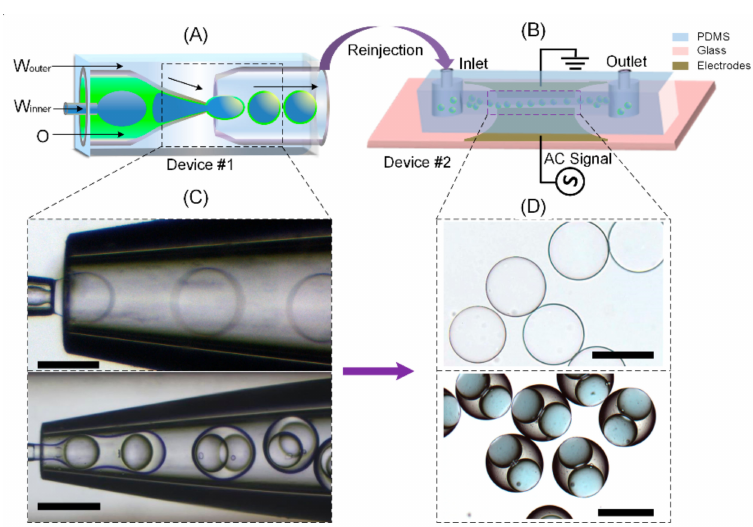
Figure 1. Generation of double emulsion droplets with single and dual cores. W outer , outer aqueous phase; W inner , inner aqueous phase; O, PDMS oil phase. ( A ) Schematic illustration of the glass capillary chip for droplet preparation; ( B ) The PDMS chip for droplet manipulation. The microscopic snapshots of droplet generation in the microfluidic chips and the droplets after generation are shown in ( C ) and ( D ), respectively. Scar bar, 300 µ